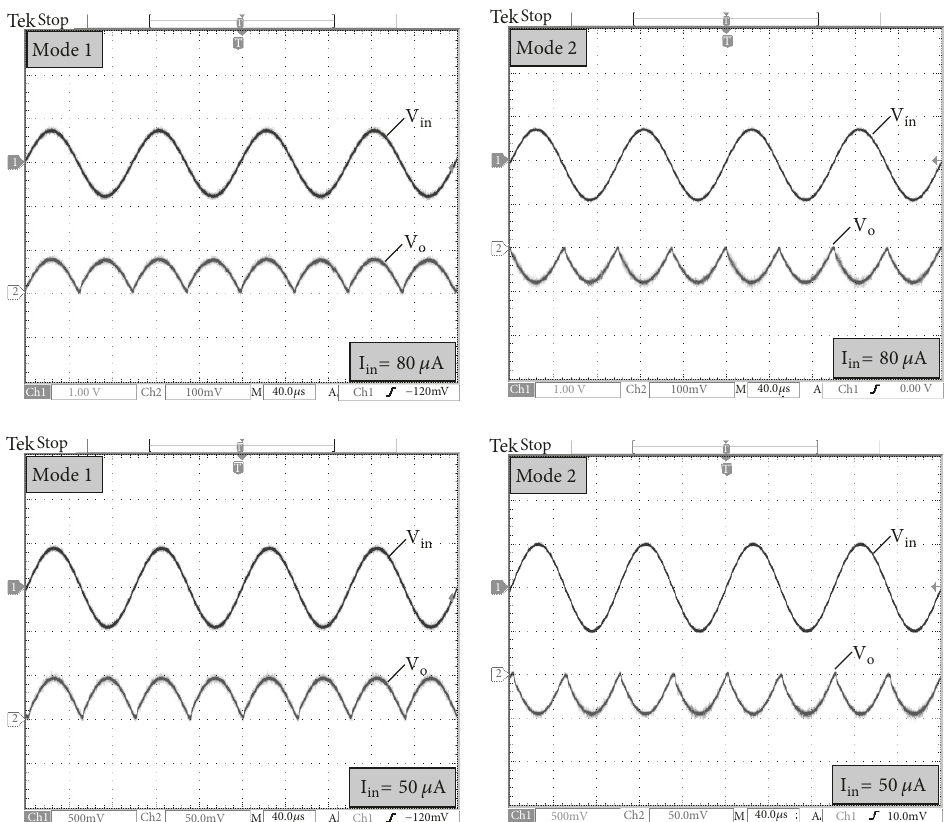
Figure 14: Experimental results of the input and rectified output waveforms of the circuit (Figure 3) for various input signal